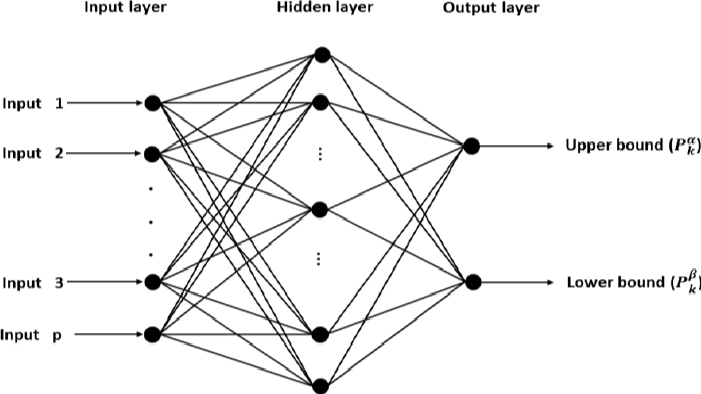
Figure 5. Architecture of a single NN in NNE2D.